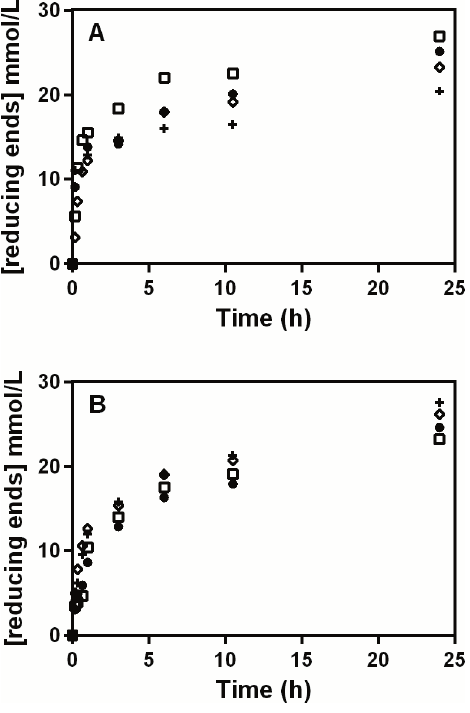
Figure 5. Short hydrolysis profiles (40 min), obtained using different pectinase complexes and either polygalacturonic acid (A) or citric pectin (B). The hydrolysis was performed at 40 u C, with an initial substrate concentration of 0.5% (w/v). The pectinase complexes used were the extracts of Aspergillus niger ( Aspergillus oryzae ( + ), produced in solid-state fermentation, and the commercially available Pectinex Ultra SPL (Novozymes) ( % ) and Pectinase P4716 (Sigma-Aldrich) ( e ). PLOS ONE |